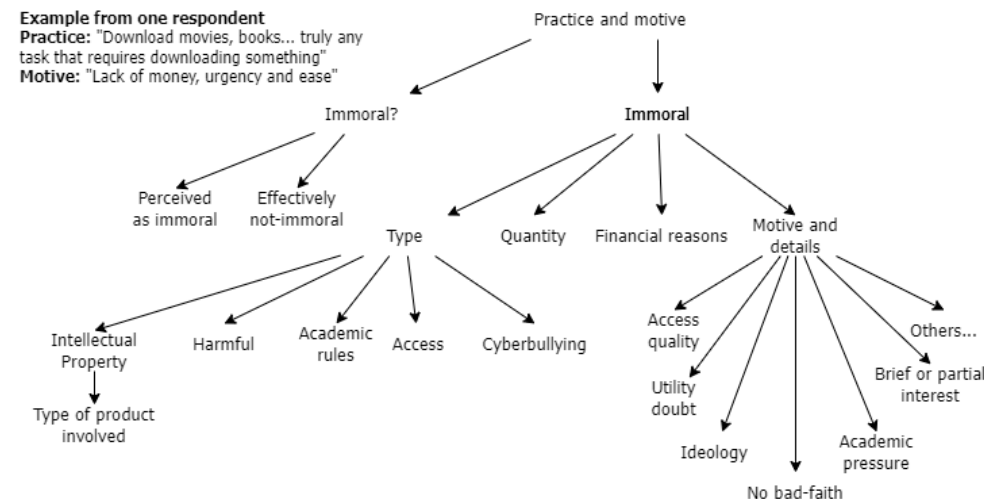
Figure 1. Coding from one response regarding practices and